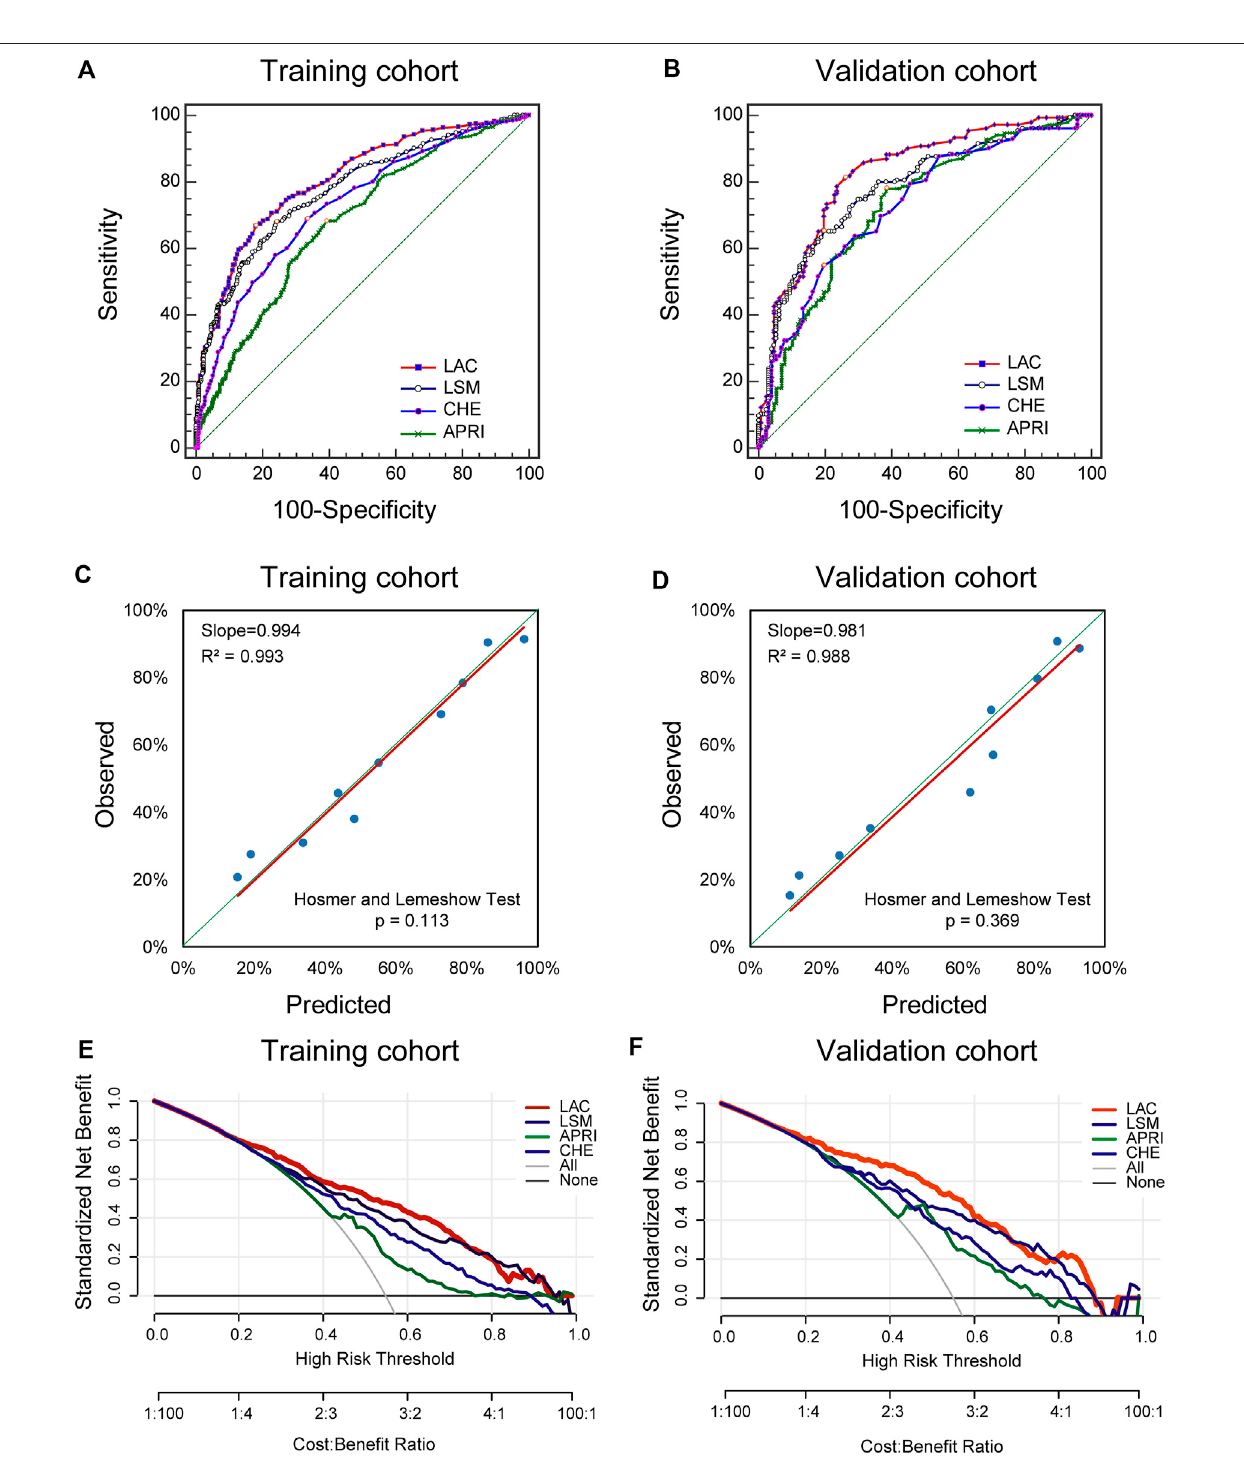
FIGURE 3 | Diagnostic Performance of Signi fi cant Fibrosis in the Training and Validation cohorts. ROC, receiver operating characteristics; LSM, liver stiffness measurement; APRI, aspartate aminotransferase-to-platelet ratio index; CHE, cholinesterase. The ROC curves of LAC, LSM, APRI, and CHE in indicating the presence of signi fi cant fi brosis in the training cohort. (A) and validation cohort (B) . Validity of the diagnostic performance of the LAC in the training cohort (C) and validation cohort (D) . The clinical utility of the LAC and its components were evaluated by decision curves in the training cohort (E) and the validation cohort (F) .